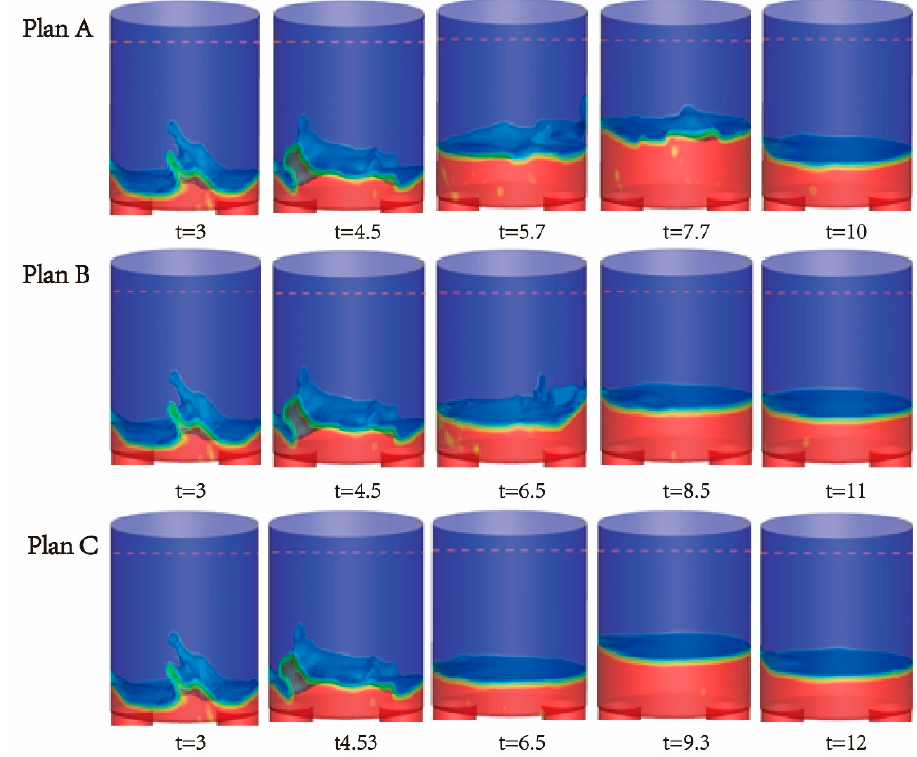
Figure 8. Fluctuation of liquid steel in vacuum chamber under di ff erent pressure drop